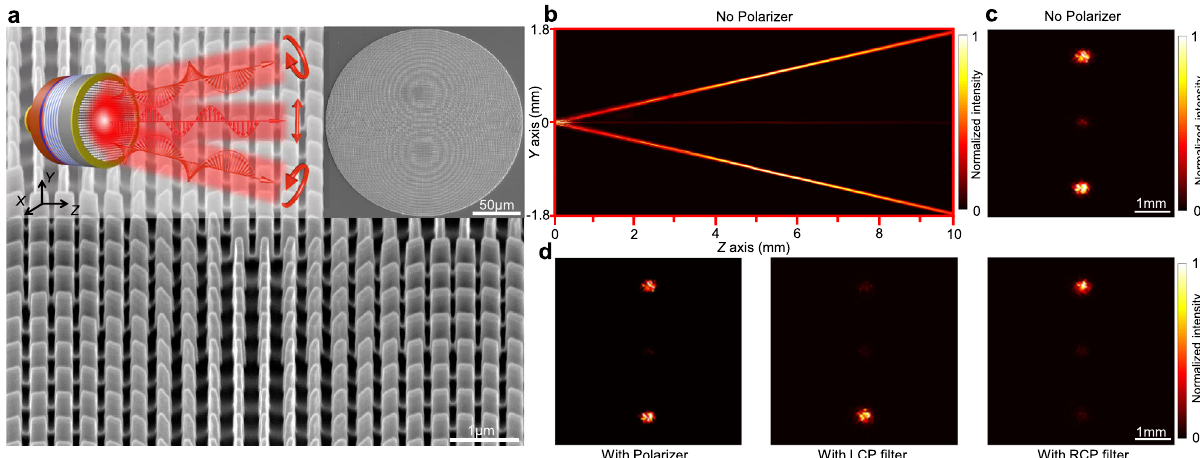
Fig. 4 | Generation of interference-free multi-polarization channels. a SEM images of the integrated Jones matrix metasurface (height 750nm) for directional collimations. The inset is a schematic illustration of a three-channel collimated VCSEL emitting directional RCP, LCP, and LP beams enabled by metasurface inte- gration. In this example, the cross-polarization components (RCP and LCP light) were modulated both by a de fl ecting PB phase pro fi le and a collimating phase imposed by the propagation phase, whilethe co-polarization component wasonly modulated by the propagation phase. As a result, the cross-polarization